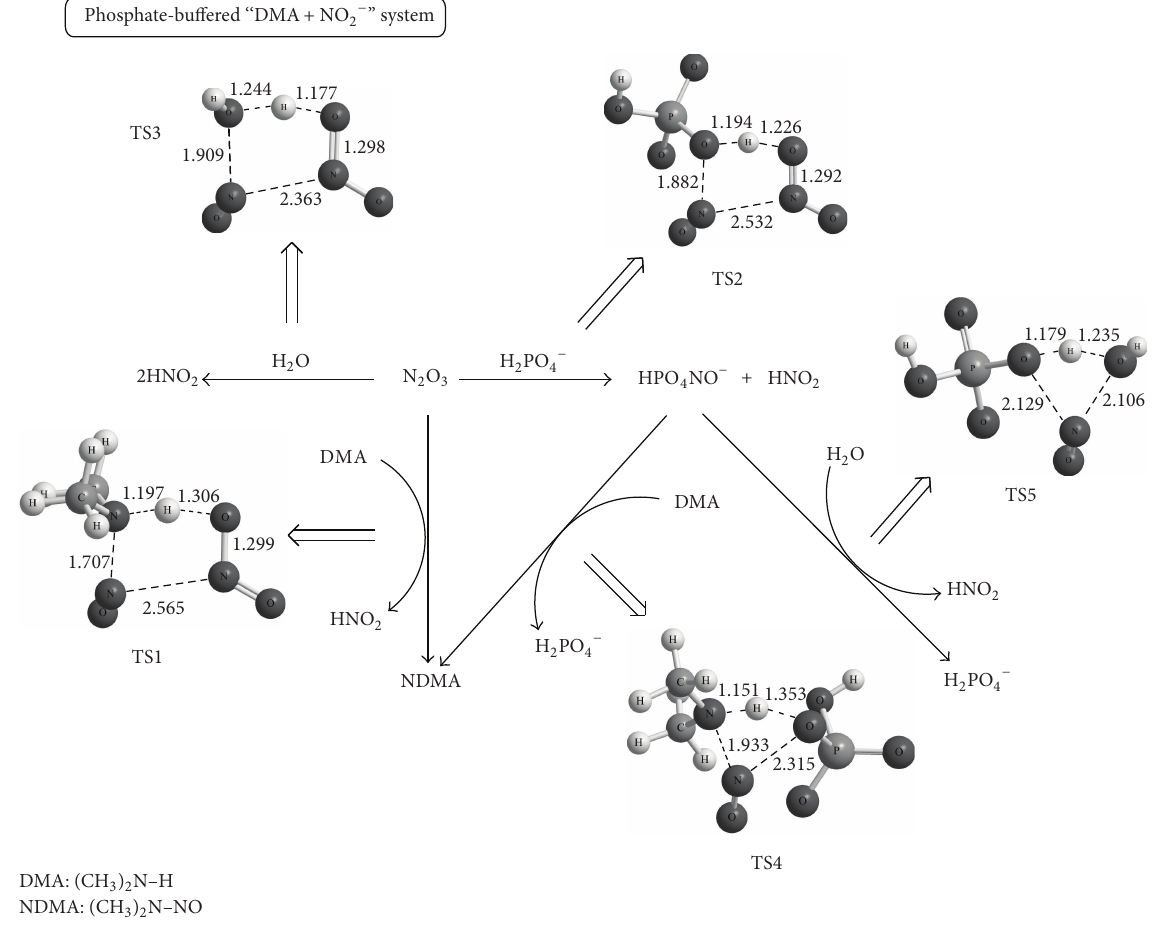
F 6: Possible reactions and transition structures (distances in angstroms) involved in the phosphate-buffered “DMA + NO system.